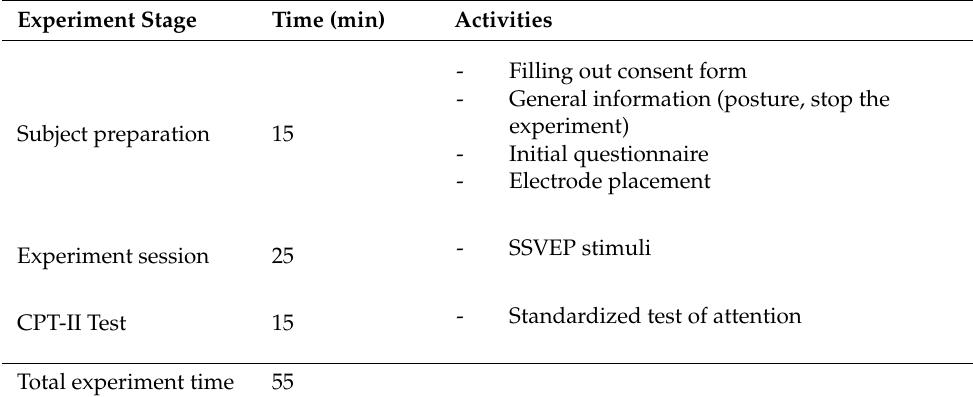
Table 2. Duration of the different parts of the